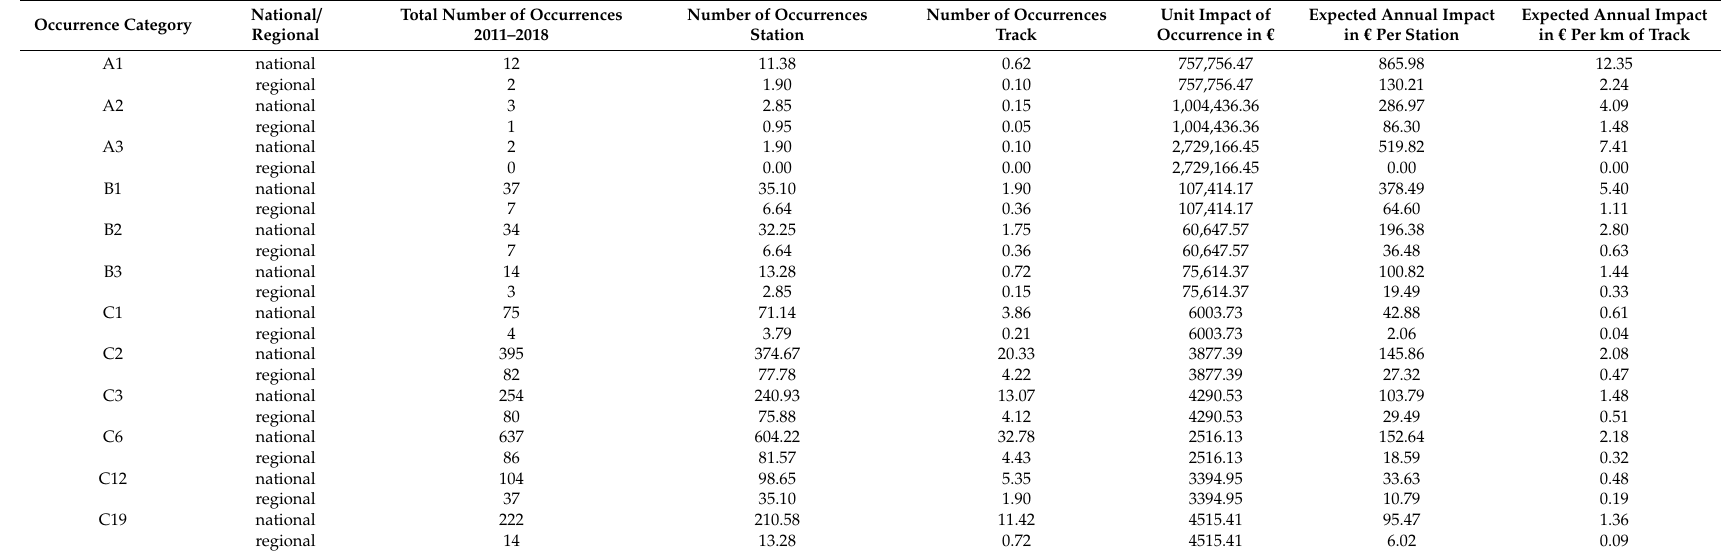
Table 6. Calculation of the expected annual impact of subcategories of occurrences per station and per km of track. Occurrence